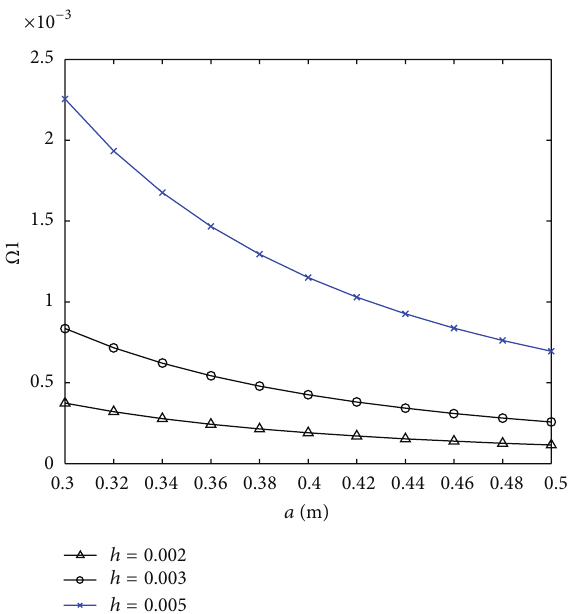
Figure 6: Variation of the first mode natural frequency with the radius of the plate for different composite layer thicknesses and clamped-clamped end conditions ( 𝑏 = 0.05 m).